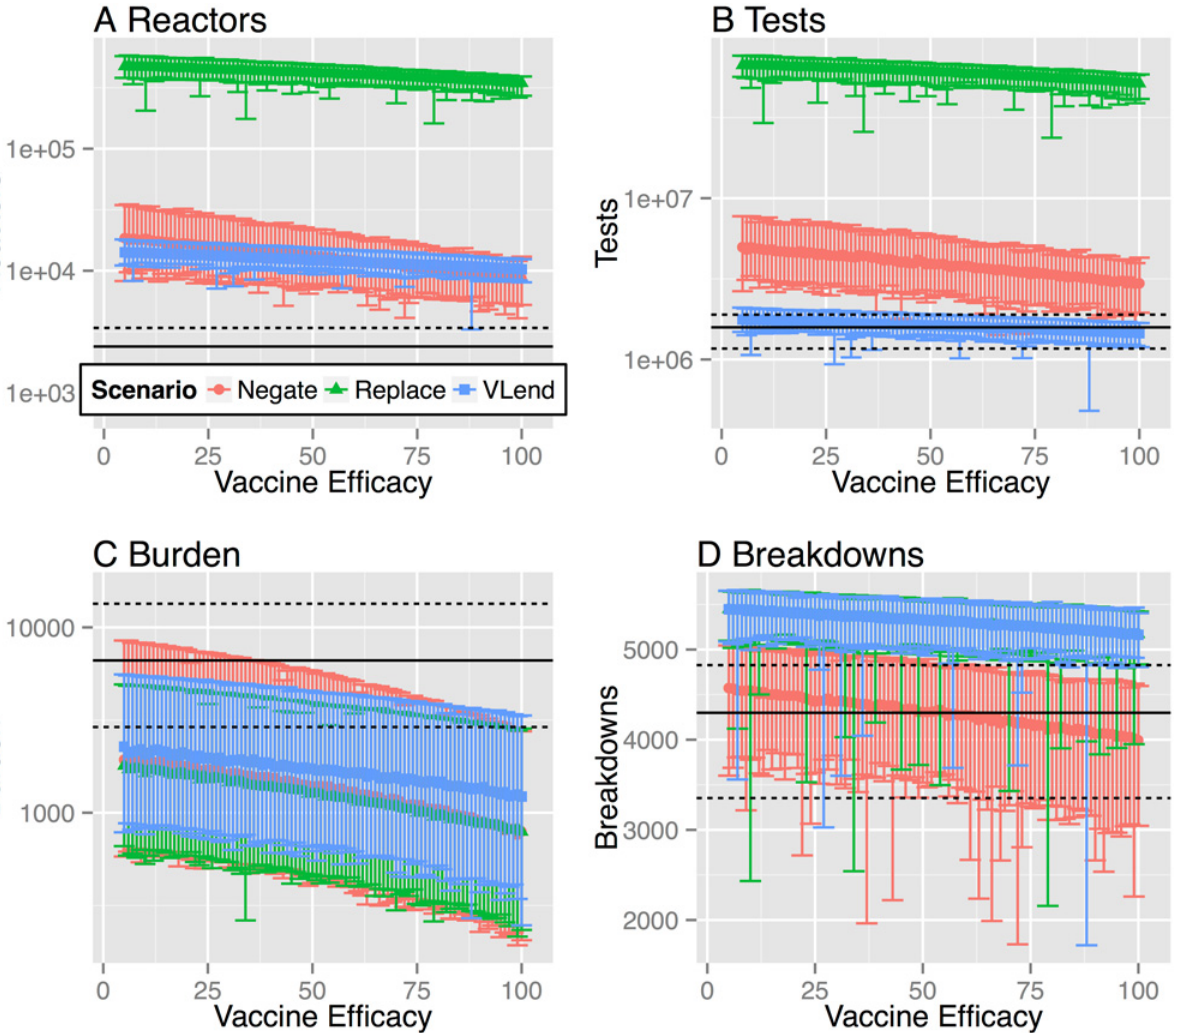
Fig 4. Break-even points for vaccine efficacy under alternative testing scenarios using γ -DIVA test. We estimate the break-even point for a protective benefit of BCG vaccination at the herd level under three alternative testing scenarios. We model DIVA testing using parameter estimates that optimize DIVA specificity of 99.4% under the constraint of maintaining a DIVA sensitivity comparable to tuberculin testing of 64.4%. We consider four key measures of the epidemiological, and economic, costs associated with bTB testing: A the number of animals condemned as reactors; B the number of tests (tuberculin and DIVA) needed to clear restrictions; C The number of infected animals left in herds after restrictions are lifted (burden of infection missed by testing) D The number of herds that experience a breakdown before the herd clears the singleton challenge. For all panels, solid black lines indicate the median break-even point for the baseline scenario with no vaccination. Dashed lines indicate the 95% quantiles of the baseline scenario. The distribution for each measure is calculated from 100 simulations with parameters drawn from the (approximate) posterior distributions of our estimated model, with each parameter set simulated once for each herd within our representative study population (of 6,601